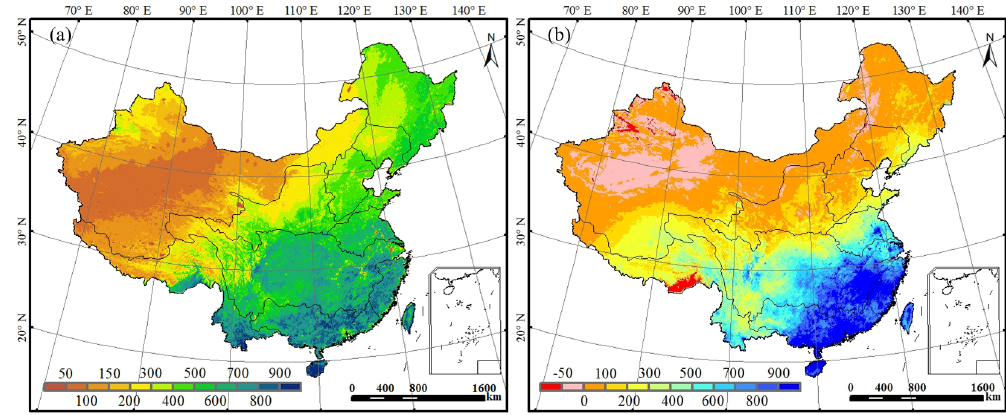
Fig. 5. The spatial distribution of (a) mean annual ET (mmyr − 1 ) and (b) water yield (mmyr − 1 ) from 2000 to 2010.